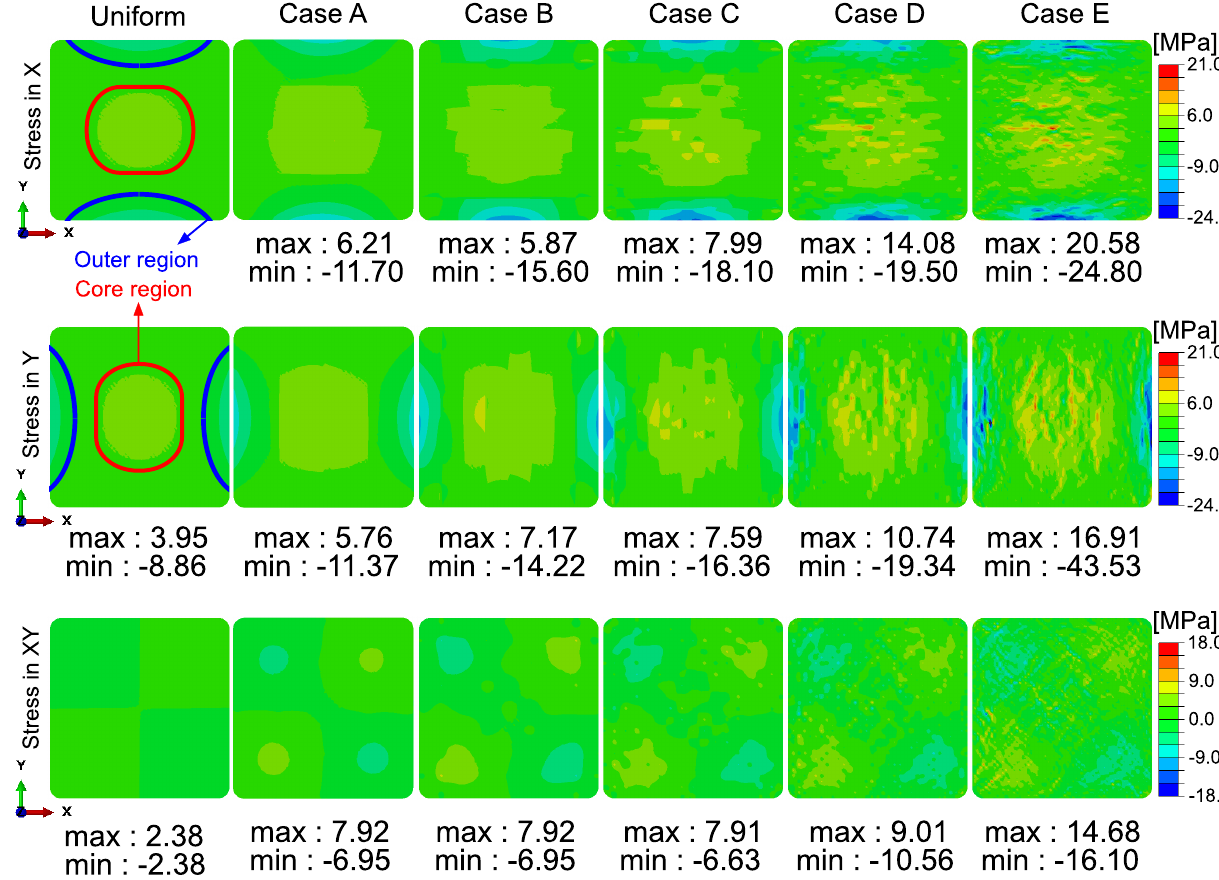
Figure 8. Residual stress distribution ( top row ; normal stress in X-direction, middle row ; normal stress in Y-direction, bottom row; shear stress (XY)) after cooling